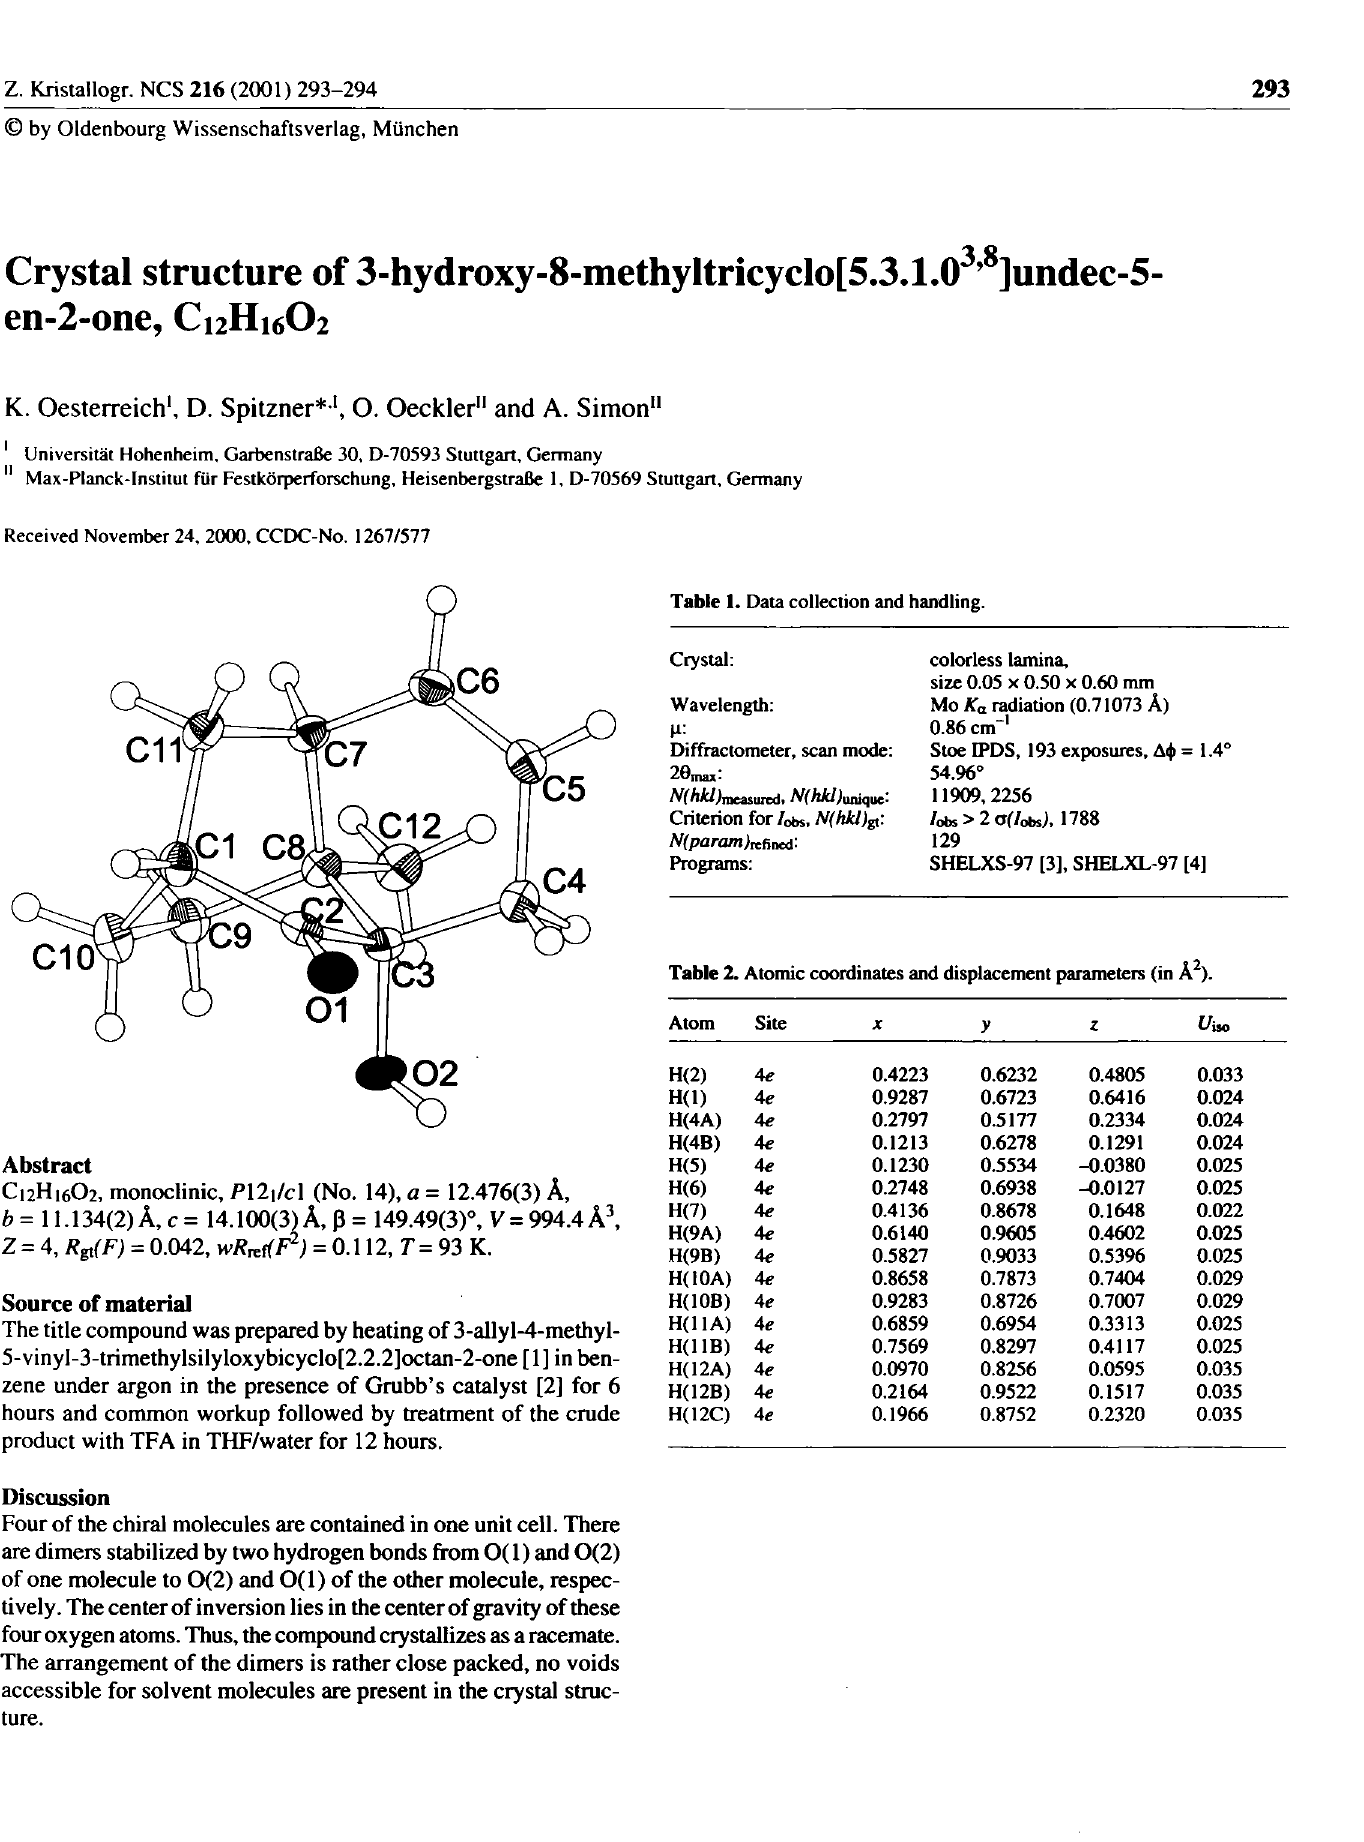
Table 2. Atomic coordinates and displacement parameters (in A 2